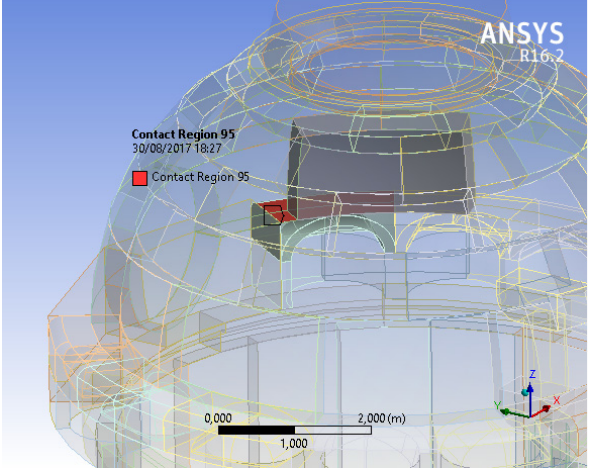
Figure 26. Rendering of one of the granite–granite contact regions. Coefficient of static friction